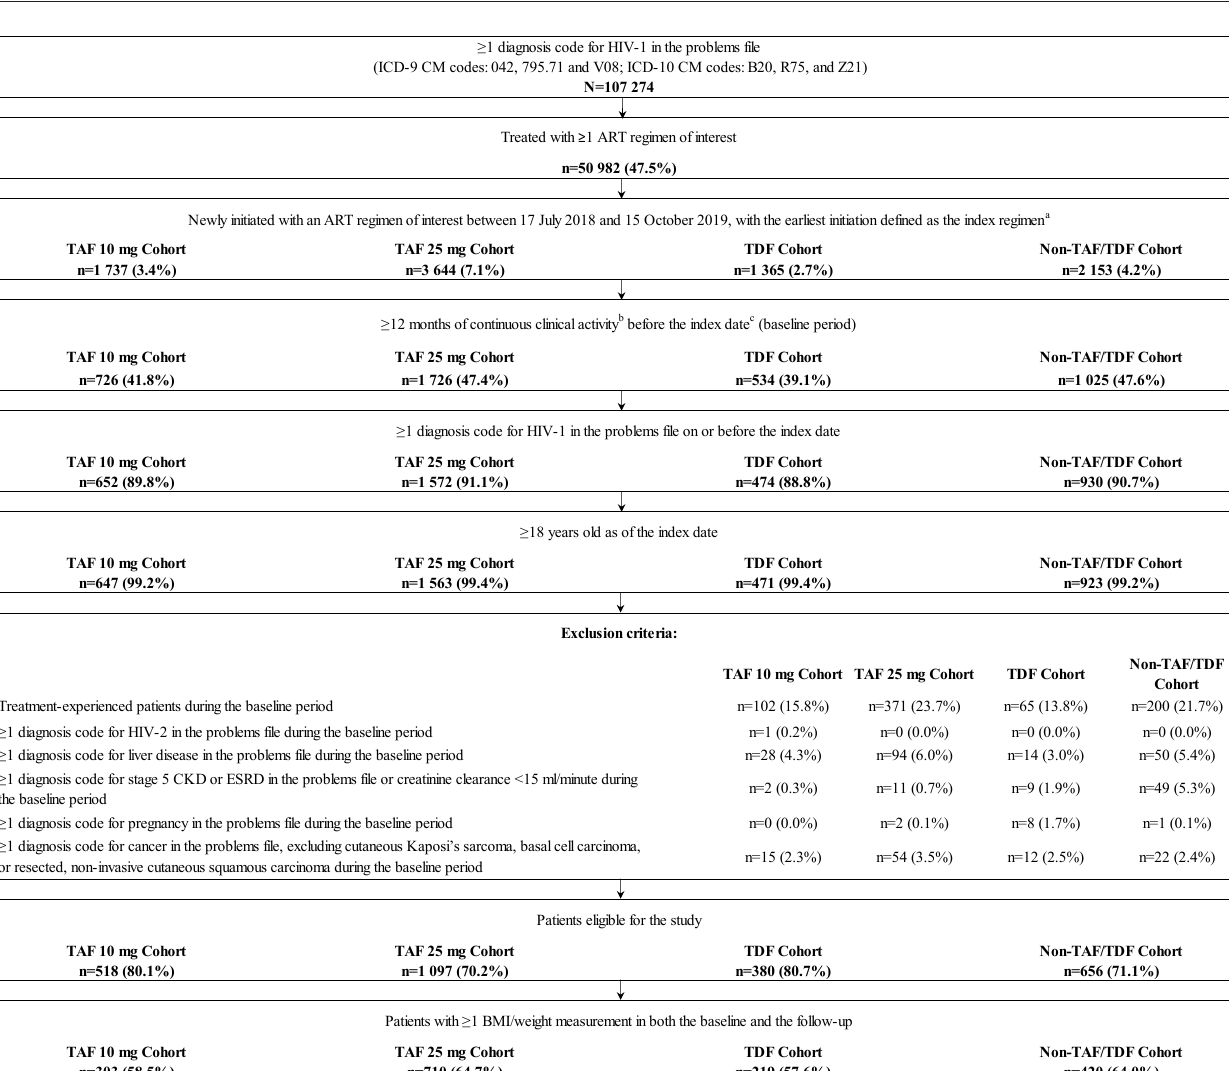
Figure 1. Identification of the Study